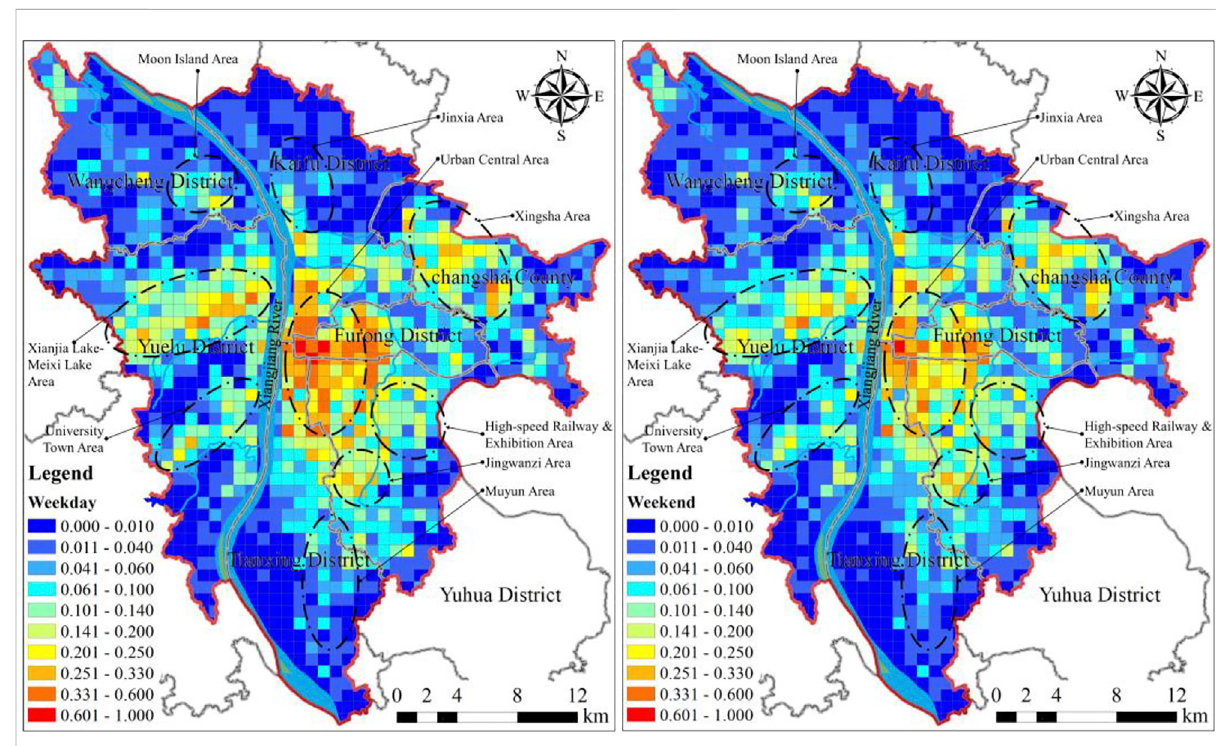
FIGURE 4 Weekday (left) and weekend (right) density of human